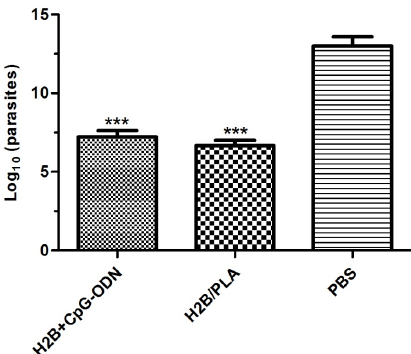
Figure 8. Parasite load in infected footpads. BALB/c mice vaccinated with H2B/PLA and H2B+CPG were challenged with L. major promastigotes, respectively. Eight weeks post-infection, footpads were collected. Parasites at the lesion site were counted by limiting dilutions. The results were compared with those obtained from PBS group. (***) p < 0.001 between PBS and protein-received